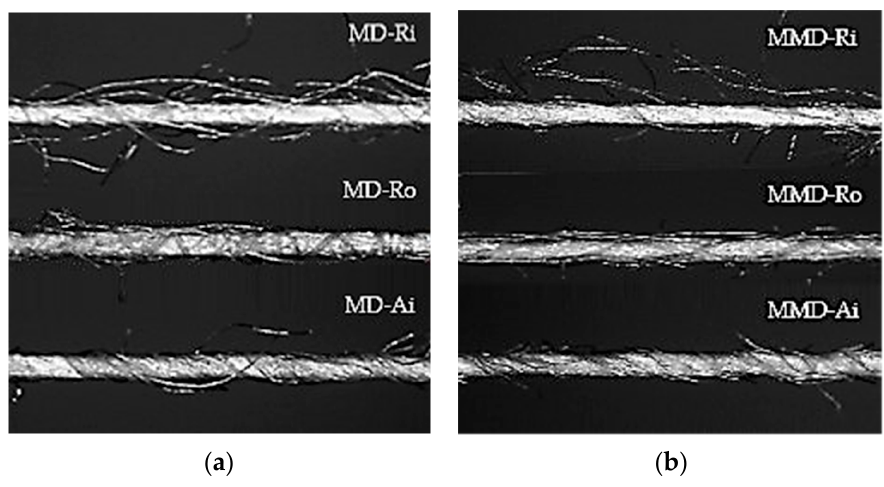
Figure 2. Optical microscopy images of the yarns’ longitudinal view (magnification 60×): ( a ) modal ring (MD-Ri), rotor (MD-Ro) and air-jet (MD-Ai) spun yarns; ( b ) micro modal ring (MMD-Ri), rotor (MMD-Ro) and air-jet (MMD-Ai) spun yarns.